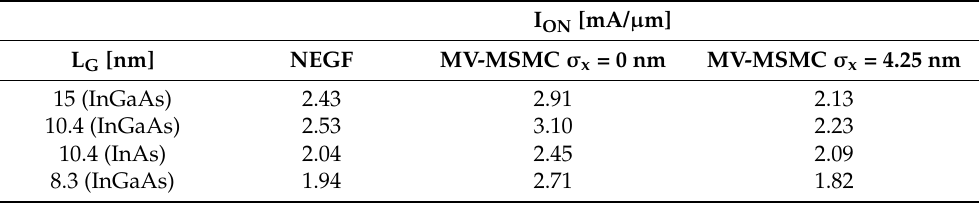
Figure 9. Comparison of ( a ) I DS -V GS , ( b ) g m , and ( c ) SS between NEGF (ascending triangles) and MV–MSMC simulations using σ = 0 nm (diamonds) and σ = 4.25 nm (descending triangles) for an InAs n-MOSFET with L G of 10.4 nm. V DS is 0.59 V. Table 1. On-current (drain current and V GS = V DS = V DD ) computed from NEGF and MV–MSMC for the devices in Figure 4. Results extracted from Figures 5–9.